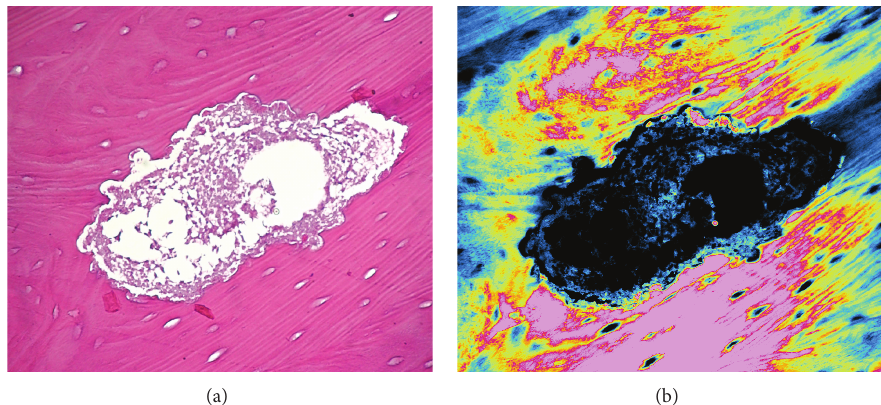
Figure 6: Internal reabsorption of Haversian canals with large and irregular appearance in traditional microscopy (haematoxylin-eosin staining × 100) and the same field in confocal laser scanning microscopy with double laser inducing fluorescence (green and red).